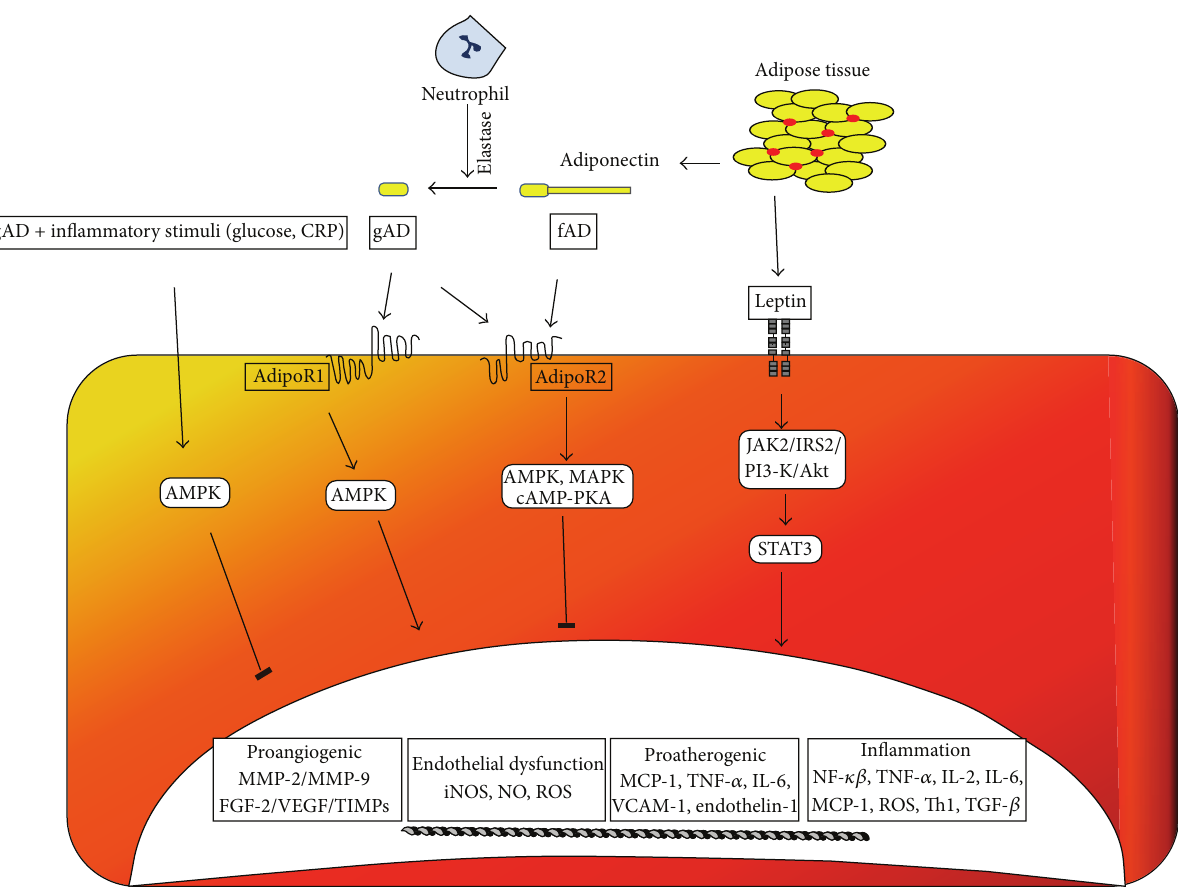
Figure 3: Differential effects of leptin and adiponectin in vascular endothelium. Dual effects of gAD and fAD on endothelium with and without inflammatory stimuli. Circulating fAD gets cleaved by leucocyte elastase (secreted from neutrophils) releasing globular domain (gAD) fraction. AdipoR1 and AdipoR2 receptors following engagement with fAD, signals downstream activating the following pathways (a) AMPK, (b) cAMP-PKA, (c) MAPK, and (d) PI3K-Akt. Activation of cAMP-PKA/AMPK causes increased NO production, decreased ROS generation, suppression of NF- 𝜅𝛽 pathway leading to reduction in IL-18, and endothelial adhesion molecule expression. These events collectively lead to a decrease in EC permeability, motility, and migration. Activation of AMPK/PI-3k/Akt signalling pathway specifically leads to eNOS phosphorylation and NO release. In vitro studies have shown that gAD independently activates NF- 𝜅𝛽 via AdipoR1/AMPK- Akt pathway. Proangiogenic/inflammatory effects of gAD have been shown to involve AMPK-Akt pathways. However, these pathways (AMPK-Akt) also contribute to an opposite effect of gAD in coexisting states of hyperglycaemia and inflammation. In hyperglycaemic and hyperinsulinaemic states, gAD improves endothelial dysfunction via activation of Akt-AMP-eNOS pathways and suppression of endothelial ROS generation via inhibition of NF- 𝜅𝛽 signalling. The binding of leptin to its receptor (OB-Rb) leads to the phosphorylation of Ob- R/JAK2 complex. Subsequent activation of downstream signalling cascades including PI3k/Akt-STAT3 activation results in transcription of genes [MCP-1, TNF- 𝛼 , IL-6/-2, and endothelin-1] involved in proatherogenic/angiogenic and inflammatory effects, potentiating endothelial proliferation. Additionally, leptin signalling in ECs also activates endothelial cell adhesion molecules, MMPs, and VEGF resulting in impaired endothelium-dependent vasodilatation promoting hypertension and